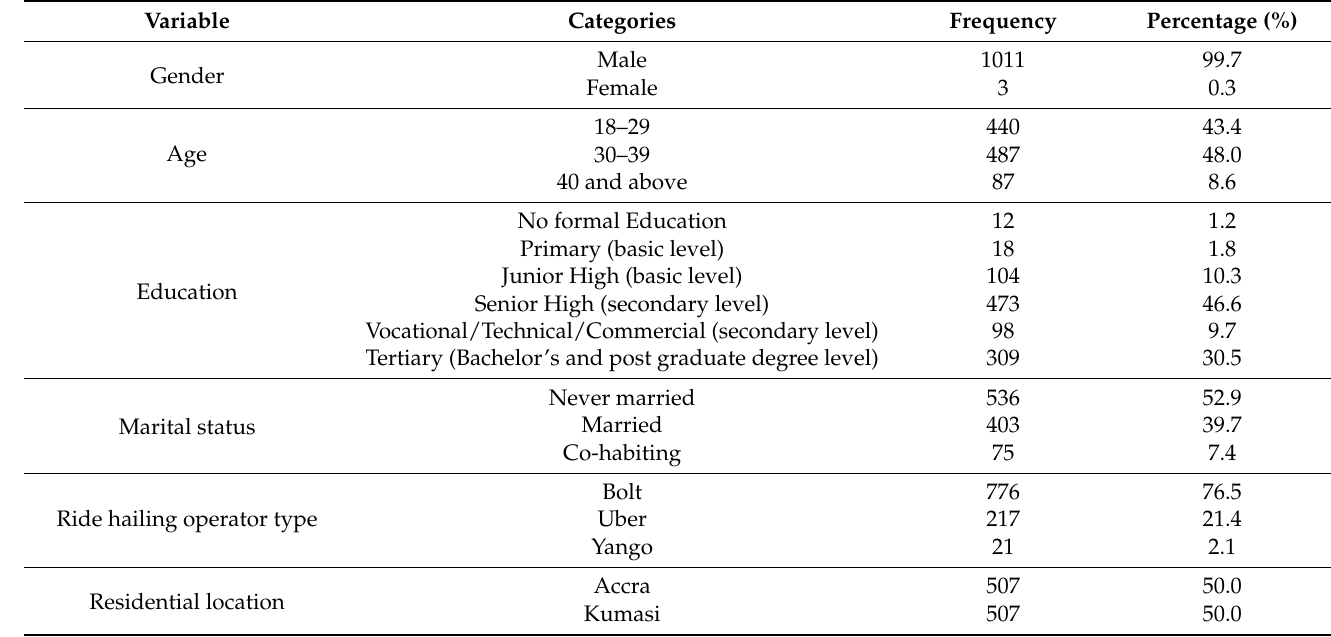
Table 2. Profile of survey